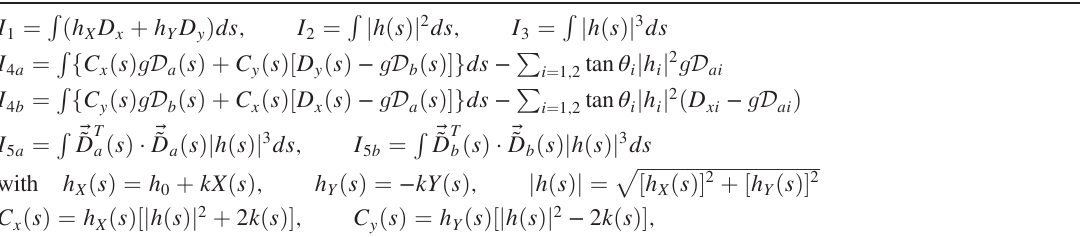
TABLE I. Radiation integrals for a general bending magnet with curvature h 0 and focusing strength k including coupling and orbit